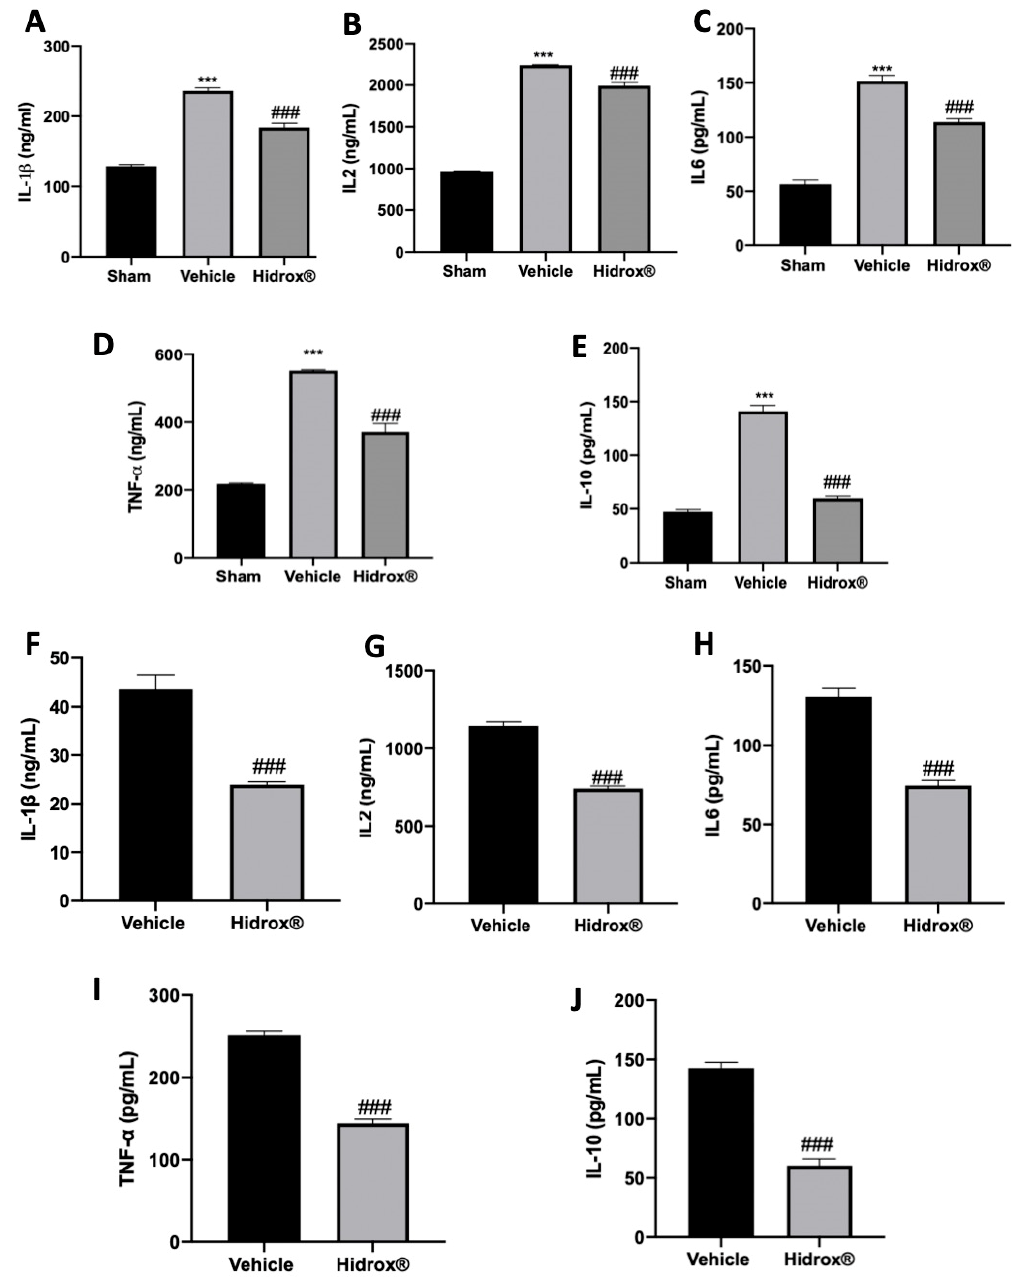
Figure 5. Hidrox ® administration reduced levels of cytokines: IL-1 β ( A ), IL2 ( B ), IL6 ( C ), TNF- α ( D ), IL-10 ( E ) levels in peritoneal fluid. IL-1 β ( F ), IL2 ( G ), IL6 ( H ), TNF- α ( I ) and IL-10 ( J ) levels in endometriotic lesions. For the analyses, n = 5 animals from each group were employed. A p -value of less than 0.05 was considered significant. *** p < 0.001 vs. sham, ### p < 0.001 vs. vehicle.